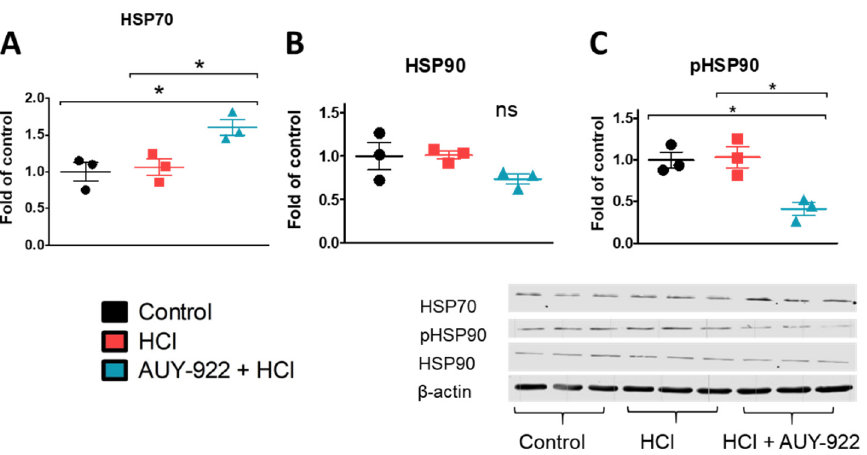
Figure 3. The HSP90 inhibitor, AUY-922, promotes the overexpression of cytoprotective mechanisms involved in endothelial barrier integrity. ( A ) HSP70 expression increased, (B) HSP90 expression did not change, while ( C ) p-HSP90 (active HSP90) decreased after 24 h incubation with AUY-922. HLMVEC grown in 100 mm culture dishes were pre-treated for 24 h with 2 µM AUY-922 and then exposed to 0.01 N HCl. One hour later, cells were lysed, and samples were prepared for protein analysis. Means ± SEM; n = 3; *: p <0.05, with one-way ANOVA and Tukey’s.